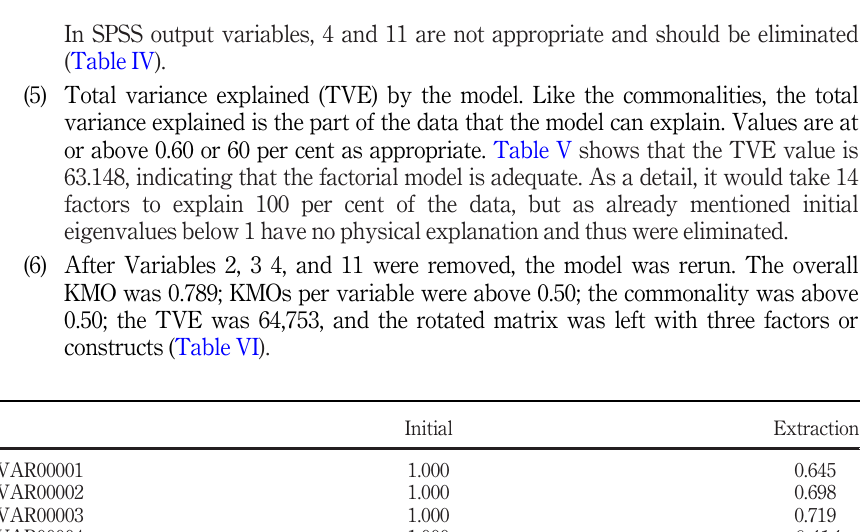
Table III. “ Fragment of the output ” of the EFA ’ s correlation matrix